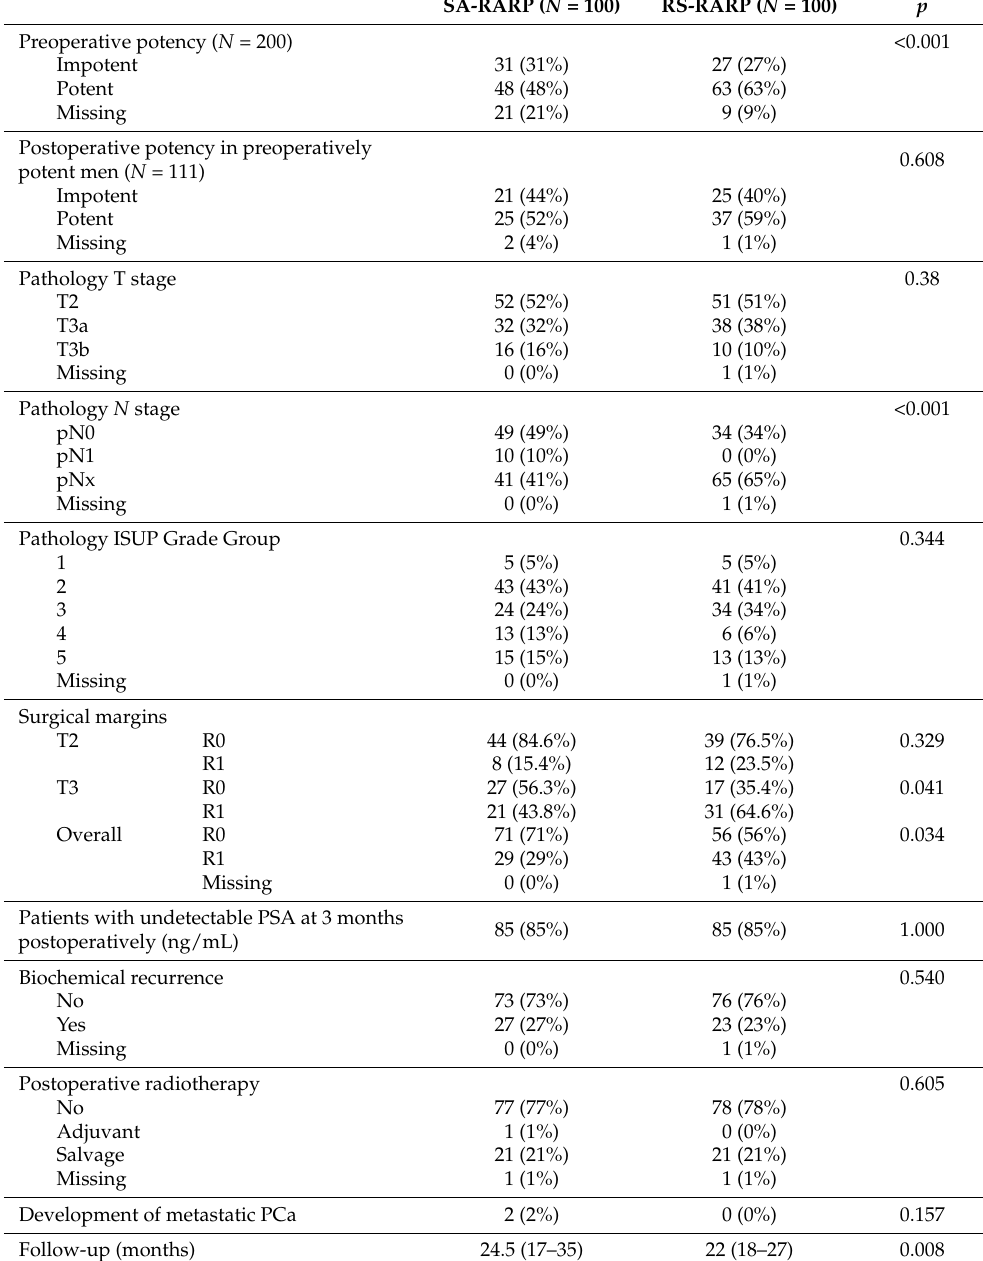
Table 4. Functional and oncological outcomes in the SA-RARP and RS-RARP